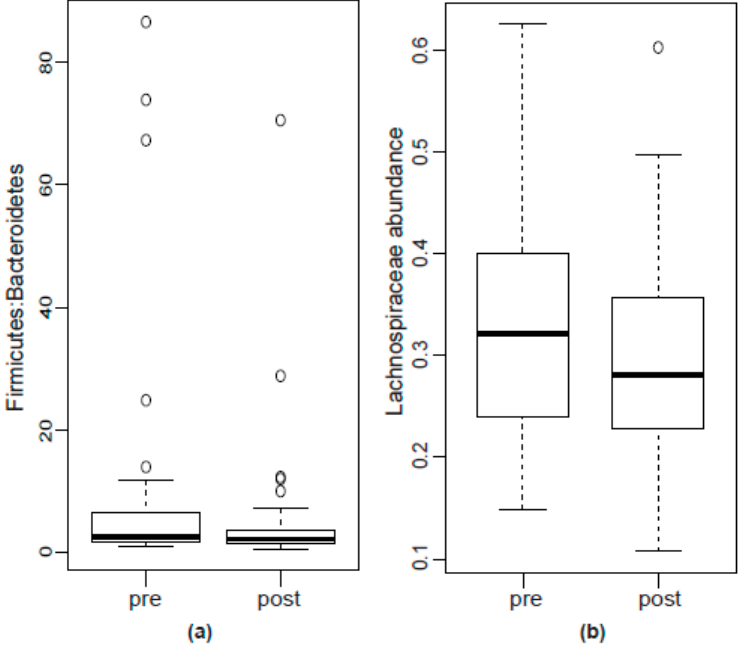
Figure 3. Boxplots of ( a ) Firmicutes : Bacteroidetes ratio and ( b ) abundance of Lachnospiraceae before and after hypnosis. None of the differences were significant.